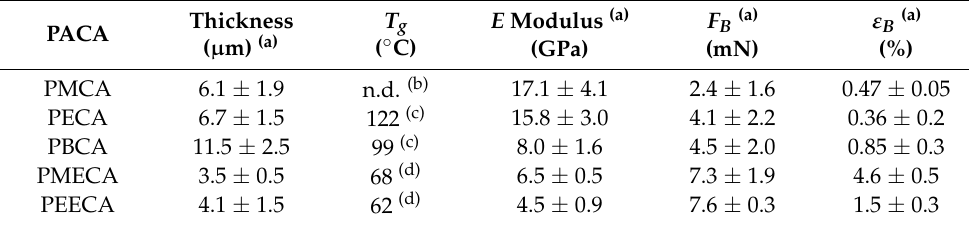
Table 2. Summary of PACA film characterization. Data represented as mean ± SD for n = 3.